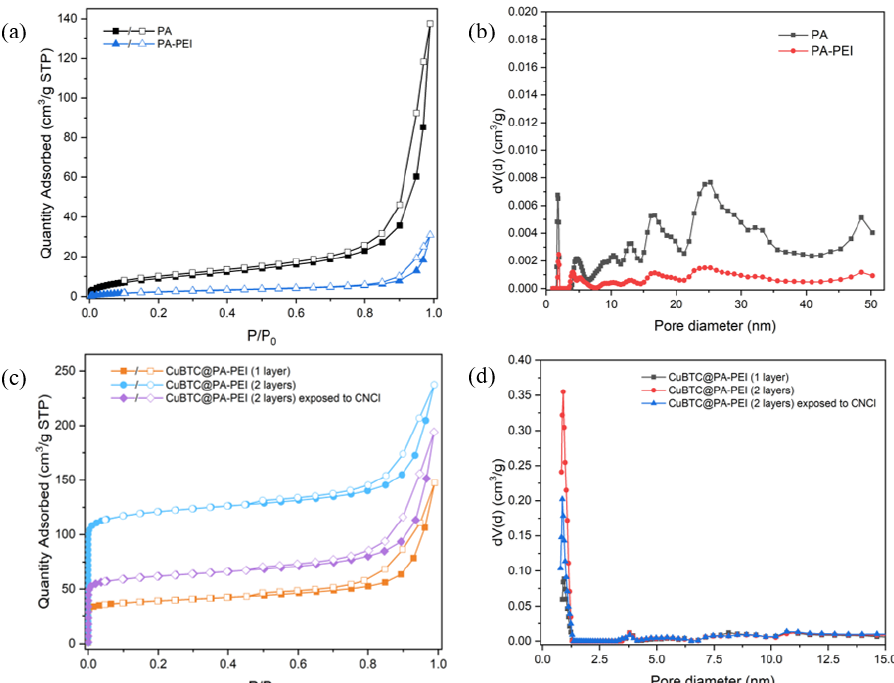
Figure 6. ( a ) N 2 adsorption-desorption isotherms of PA and PA-PEI; ( b ) DFT pore size distributions of PA and PA-PEI; ( c ) N 2 adsorption-desorption isotherms of CuBTC@PA-PEI (1 layer), CuBTC@PA- PEI (2 layers) and CuBTC@PA-PEI (2 layers) exposed to CNCl; ( d ) DFT pore size distributions of CuBTC@PA-PEI (1 layer), CuBTC@PA-PEI (2 layers) and CuBTC@PA-PEI (2 layers) exposed to CNCl. Table 1. S BET of the PA, PA-PEI, and CuBTC@PA-PEI samples before and after the CNCl exposure.